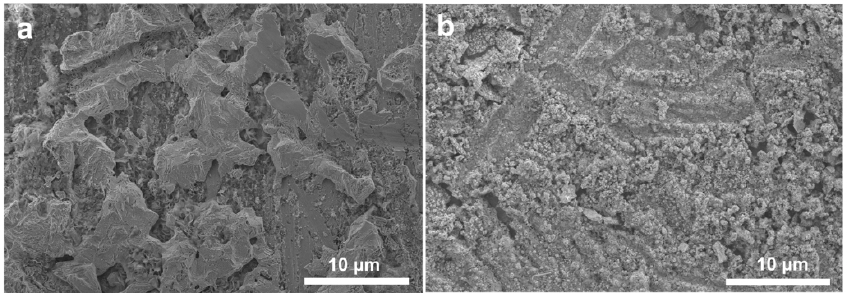
Figure 5. SEM images of ( a ) Zn and ( b ) Cu–Zn after 30 cycles at a current density of 5 mA cm − 2 with a capacity of 1 mAh cm − 2 .